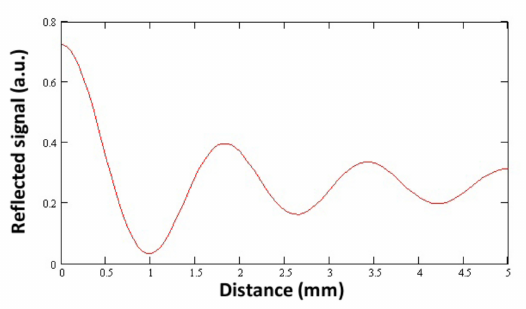
Figure 18. Variation of the signal as a function of the distance of the target. A large variation occurs for small